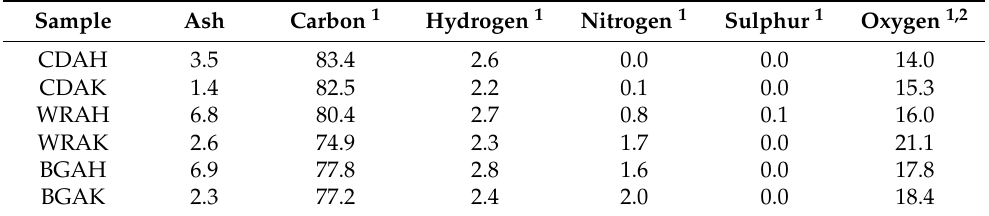
Table 1. Elemental composition of the activated carbons prepared via the chemical activation with H 3 PO 4 and K 2 CO 3 . Sample Ash Carbon 1 Hydrogen